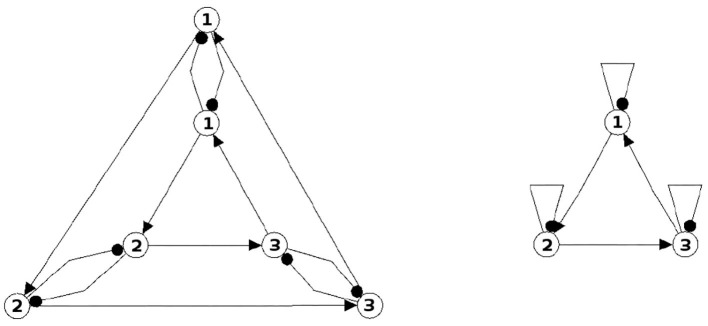
A six-neuron neuromodule (left) which is s-decomposable and the resulting synchronization core CS(w+) (right), showing that its s-decomposition is generative.